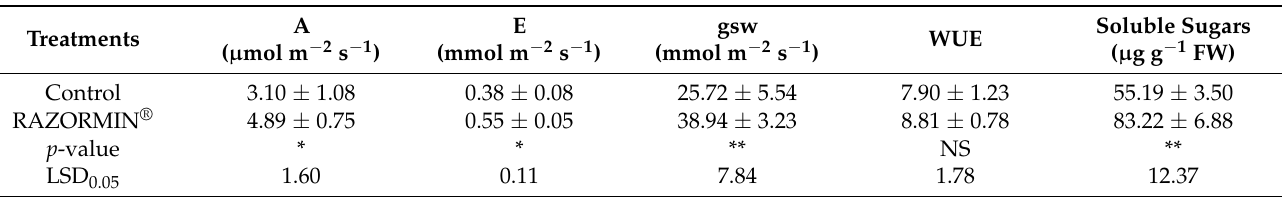
Table 2. Effect of the biostimulant RAZORMIN ® application on photosynthesis and foliar concentra- tion of soluble sugars in pepper plants.